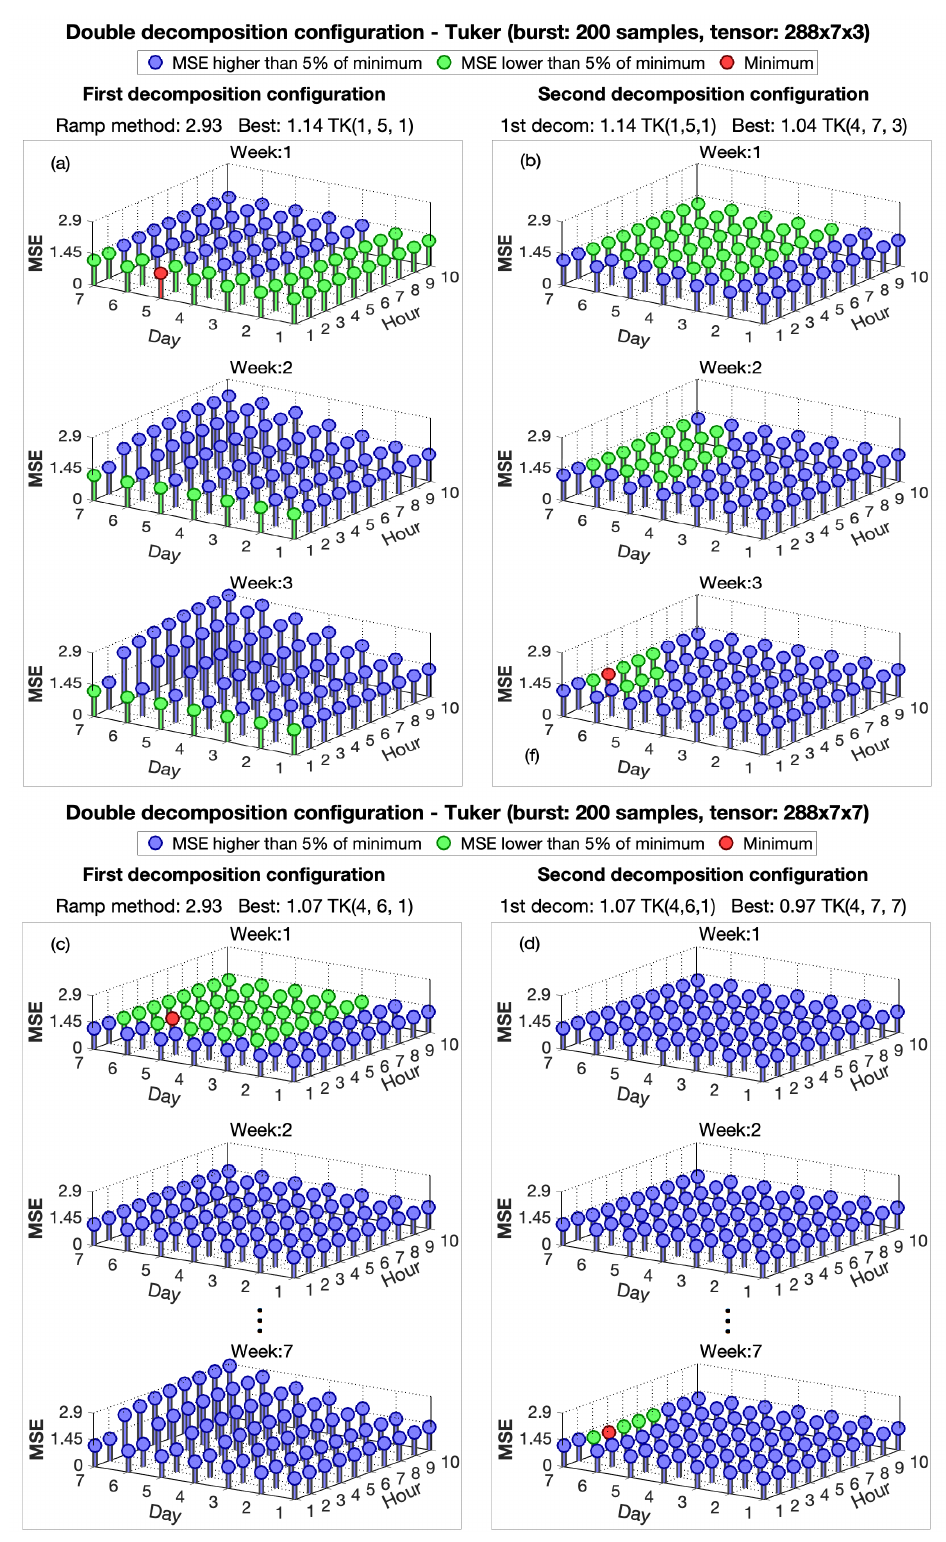
Figure 10. Test of the double decomposition configuration with the Tucker model and a burst of 200 samples. ( a , c ) show the MSE of the first decomposition procedure for different core configurations. ( b , d ) show the MSE of the second decomposition for different core configurations and using the best core configuration obtained on ( a ) or ( c ) in the first decomposition,